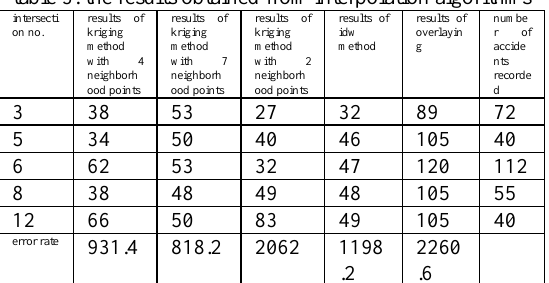
table 3. the results obtained from interpolation algorithms intersecti on no.